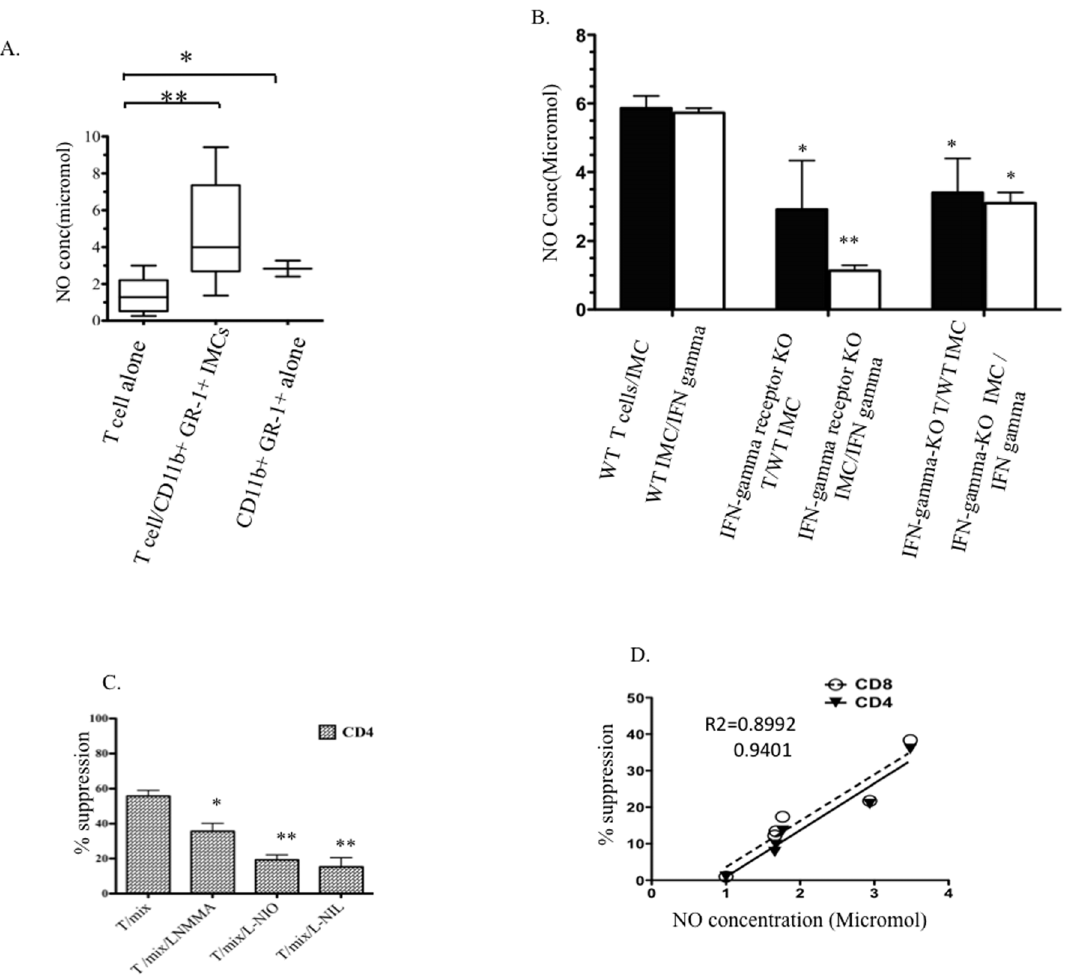
Figure 6. T-cell inhibition is mediated by an IFN- c /NO pathway. Supernatants were collected after 4–5 days of co culturing Dynabead- activated T-cells with CD11b + GR-1 + immature myeloid cells sorted from BM. A) NO concentration in the supernatants of wild-type T-cells with and without wild-type IMCs ( p =0.0033). B) NO concentration in the supernatants of combinations of wild- type T-cells with IMCs, wild type T-cells with IFN- c receptor KO IMCs, and IFN- c KO T-cells with wild type IMCs (black bars from left to right). White bars show NO concentrations in supernatant of IFN- c (50 ng/ml) treated IMCs cultures FACS-purified from wild type, IFN- c receptor KO, and IFN- c KO BM. Data represent mean and SD of four experiments. C) Inhibition of Dynabead-induced proliferation of CD4 + T-cells with mix of both subunits CD11b + GR-1 hi and GR-1 low in the presence and absence of NO inhibitors p =0.0419. D) Correlation of NO production and inhibition of proliferation in co-cultures containing different ratios of CD11b + GR-1 + IMCs: T-cells. Solid and dashed lines represent best-fit correlation of NO concentration with inhibition of proliferation of CD4 + and CD8 + T-cells. (* Indicates p , 0.05 , ** indicates p , 0.001 ).